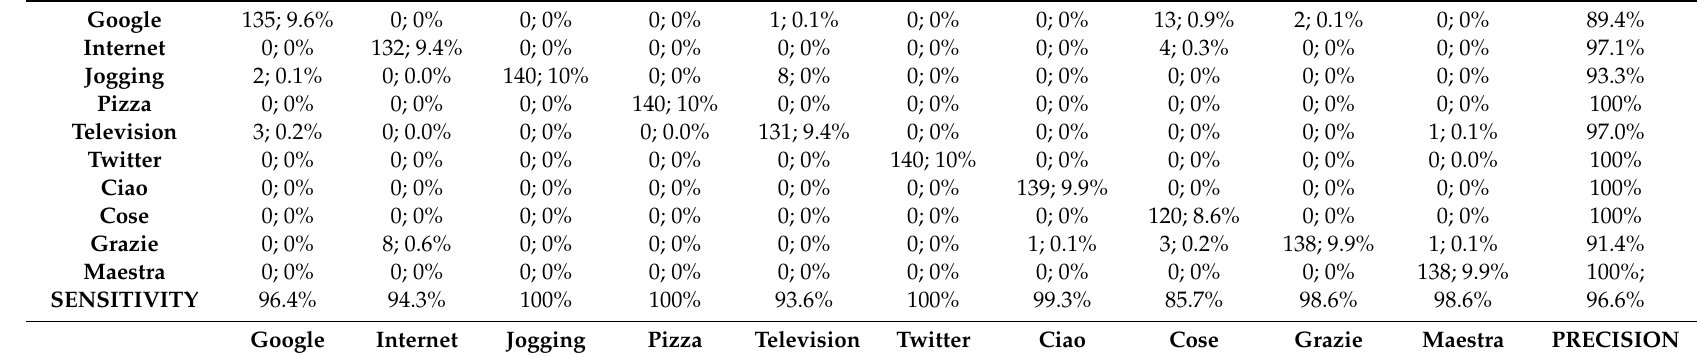
Table 1. Confusion matrix for the k-NN and DTW classification model.